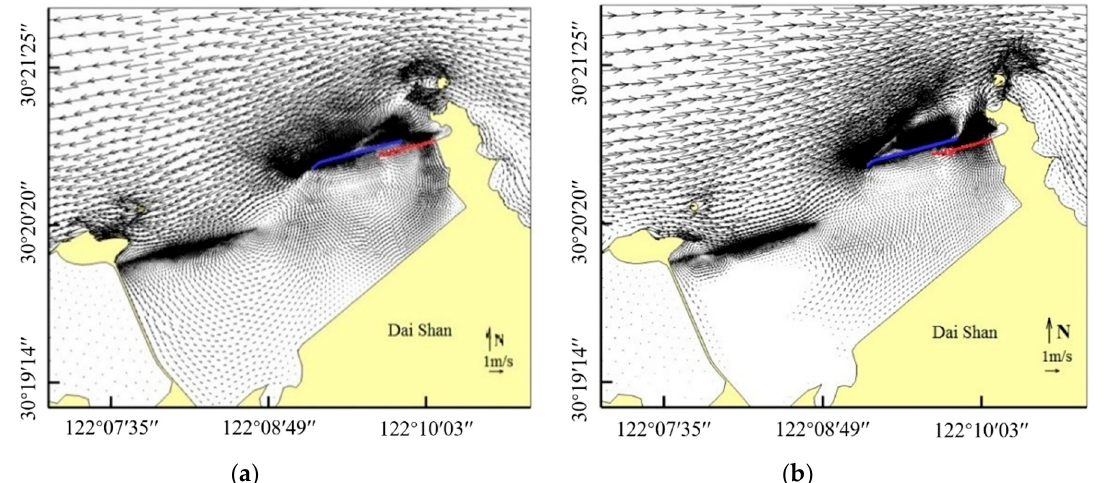
Figure 14. The maximum flow vectory map of flood and ebb tide after plan II implementation. ( a ) Flood tide, ( b ) Ebb tide.